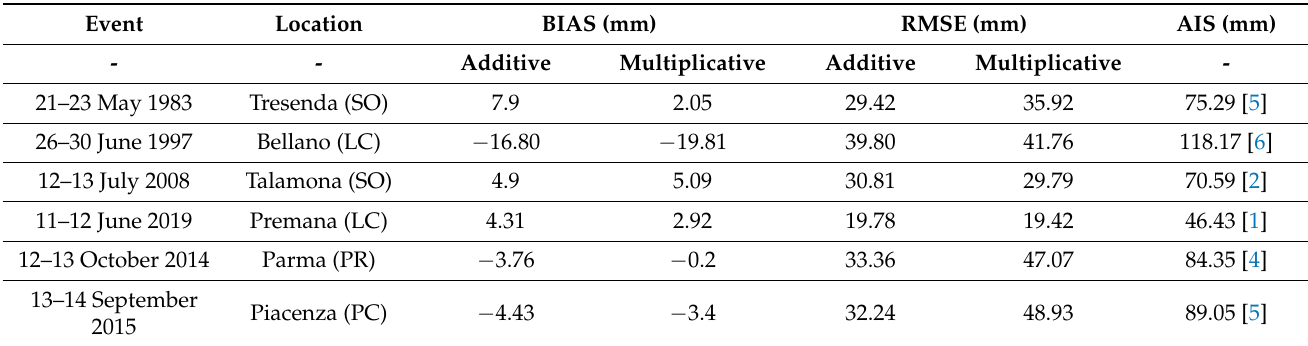
Table 4. Error calculation in LUME for the event examined with the two error models. For the event of Parma 2014, two rain gauge stations (Berceto and Musiara Superiore) were excluded since they were suspected to be outliers or not representative of that